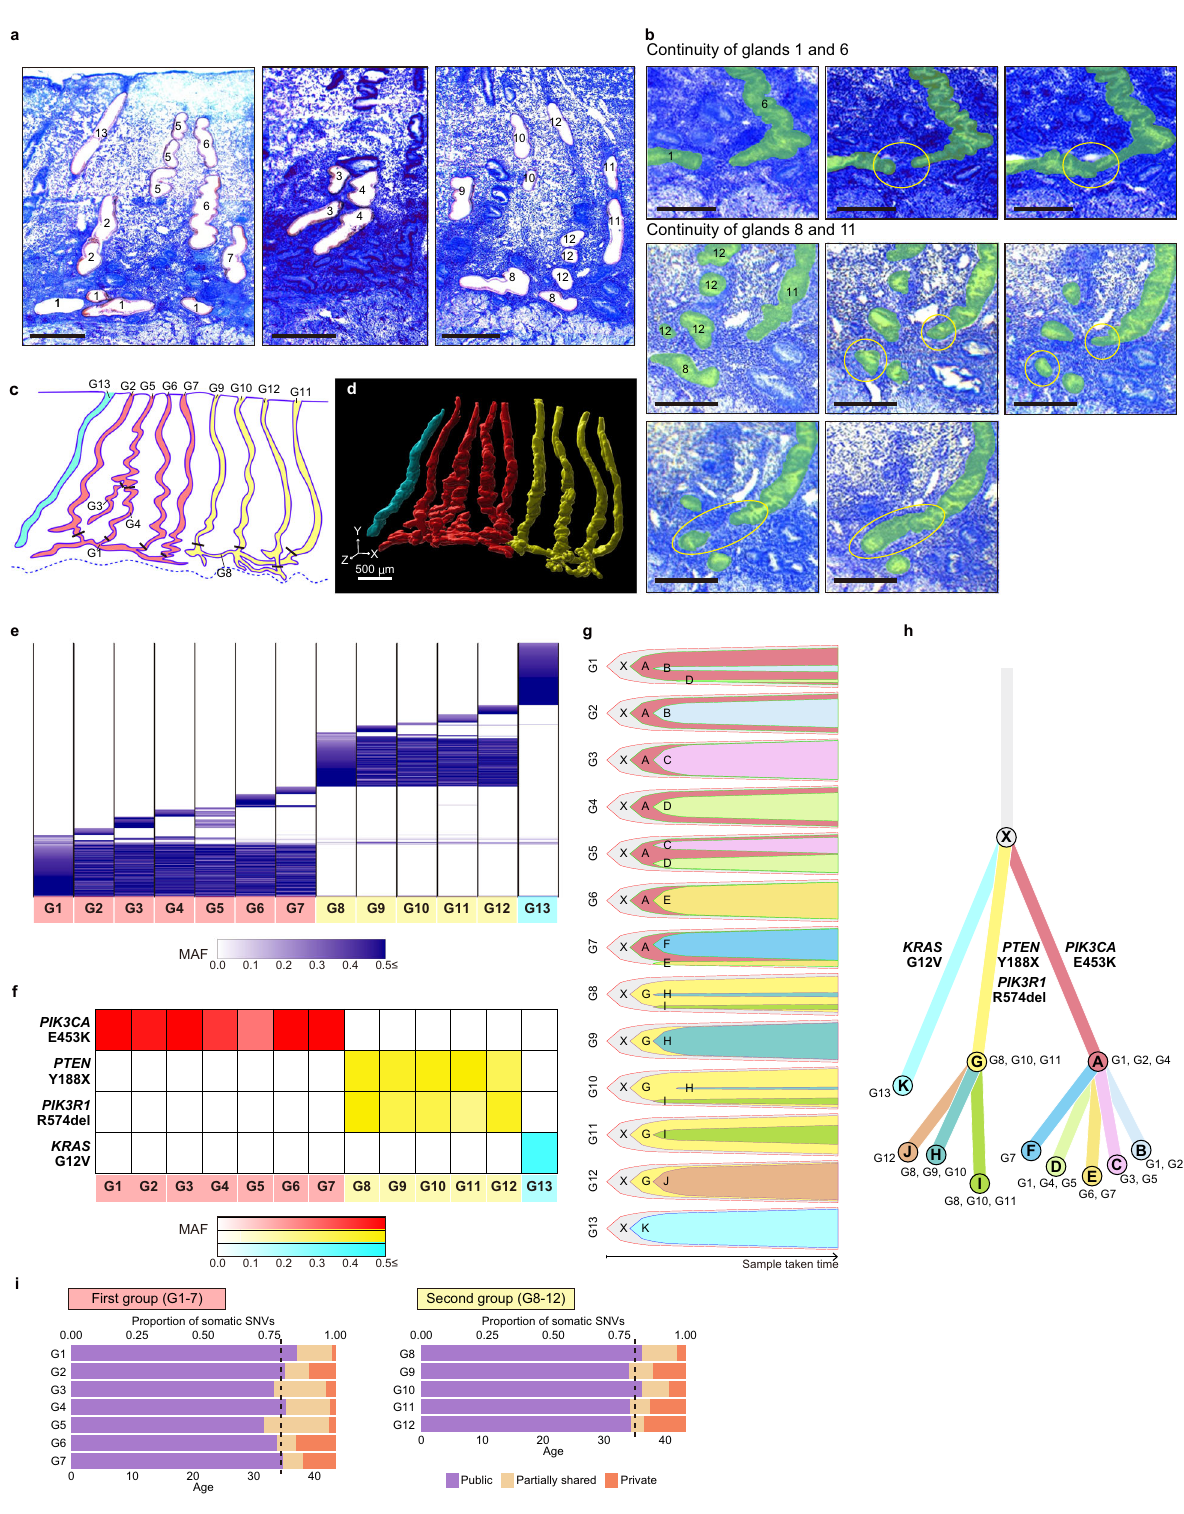
2.9.10) 75 . For somatic indel calling, we utilized the information about candidate indel sites provided by Manta (Version 1.6.0) 76 . The variants whose empirical variant scores provided by Strelka2 were greater than 13.0103 ( = − 10 ×log 10 0.05) were used for subsequent analyses. In addition, we excluded variants whose fre- quencies were greater than or equal to 0.001 in any of the general populations from the 1000 Genomes Project 77 , the National Heart, Lung, and Blood Institute (NHLBI) GO Exome Sequencing Project 78 , and the Genome Aggregation Database (gnomAD) 79 to prevent false-positive variant calls. Functional annotations for the protein-coding and transcription-related effects of the identi fi ed variants were implemented by Ensembl Variant Effect Predictor (VEP) 80 . Curated